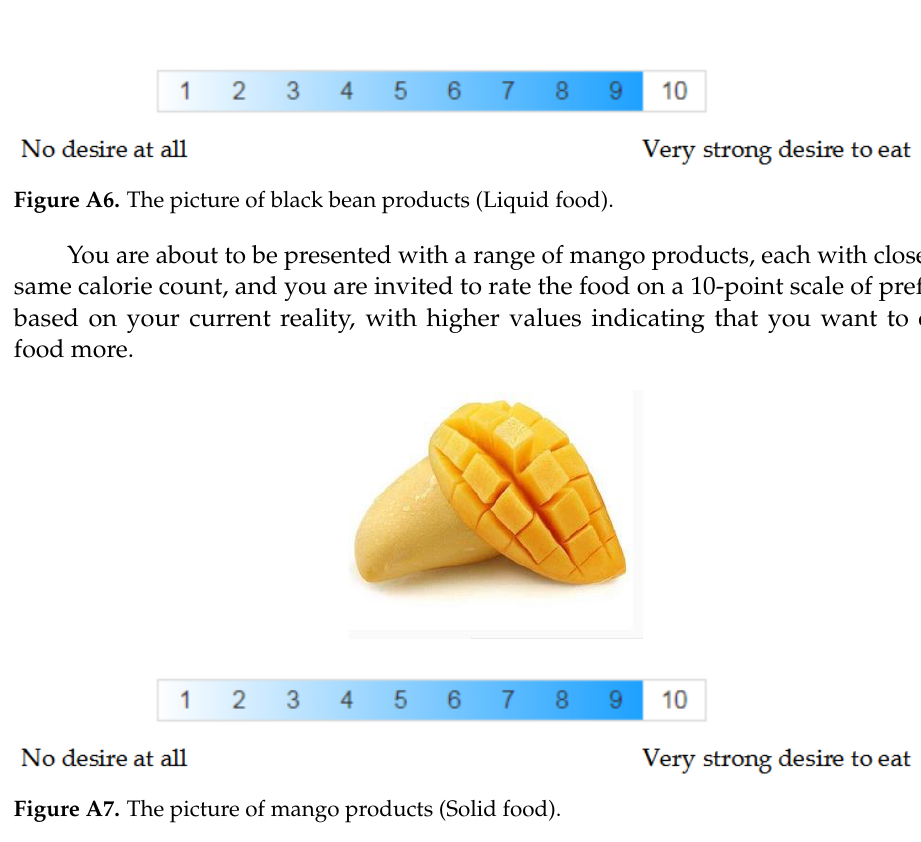
Figure A7. The picture of mango products (Solid food).